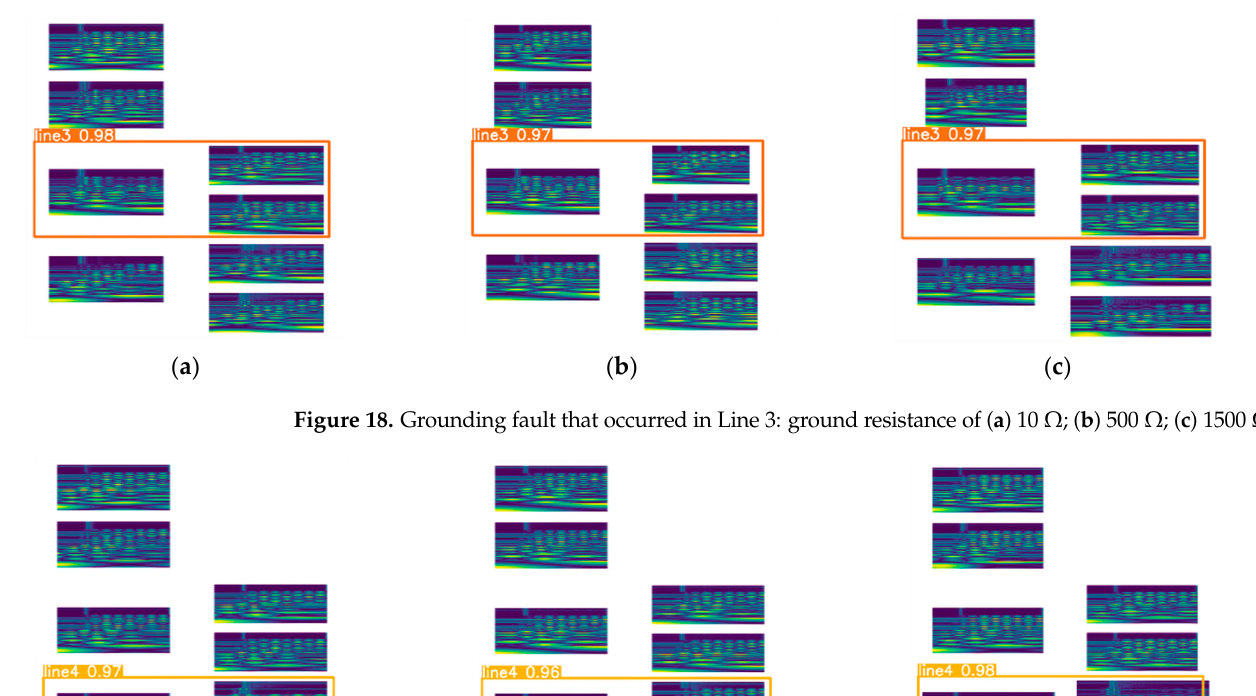
Figure 17. Grounding fault that occurred in Line 2: fault initial phase ( a ) 0°; ( b ) 6 0°; ( c ) 120° .